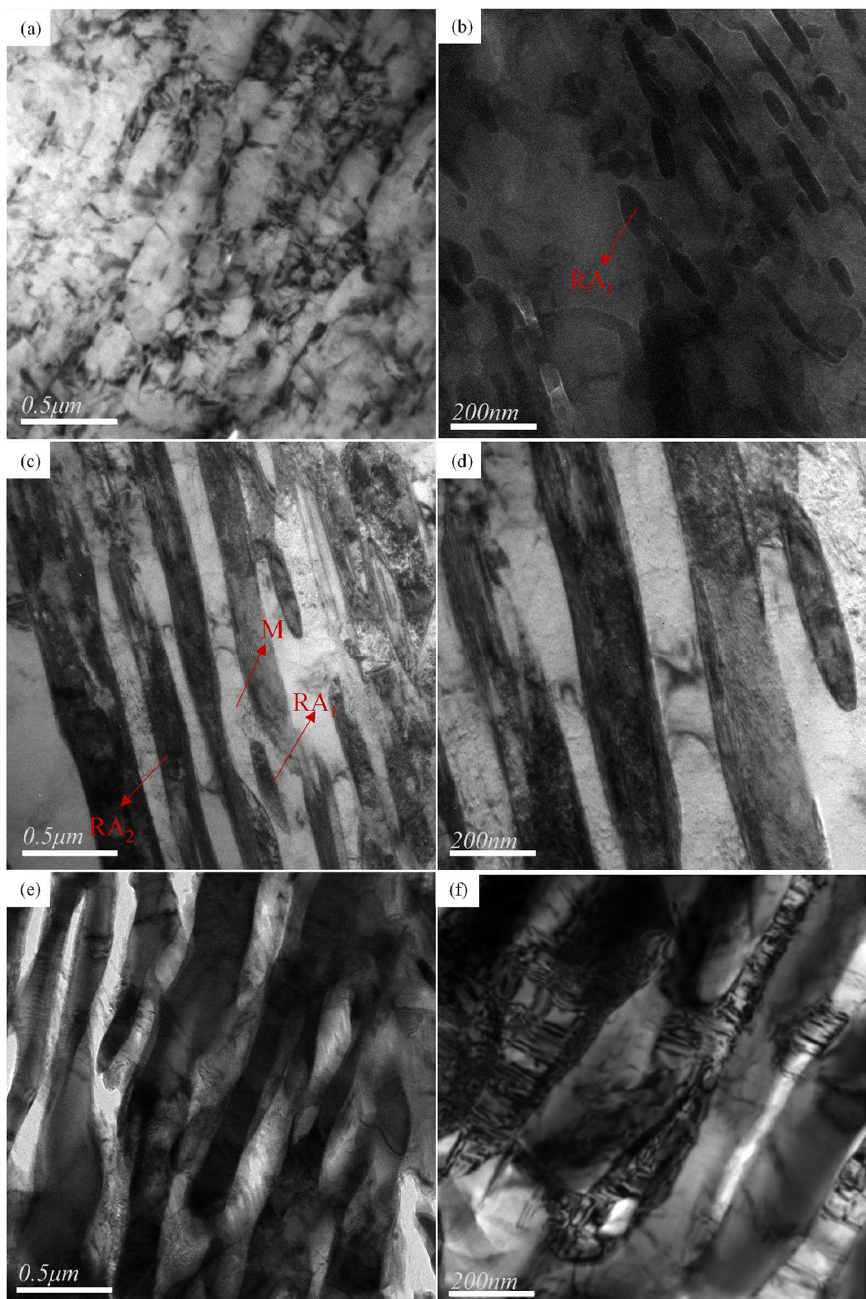
Figure 8. ( a , b ), ( c , d ) and ( e , f ) are the transmission electron microscope bright field images of QP-300, IA-680 and QA-680, respectively, in which M is lath martensite, RA1 is granular residual austenite, and RA2 is thin film residual austenite.